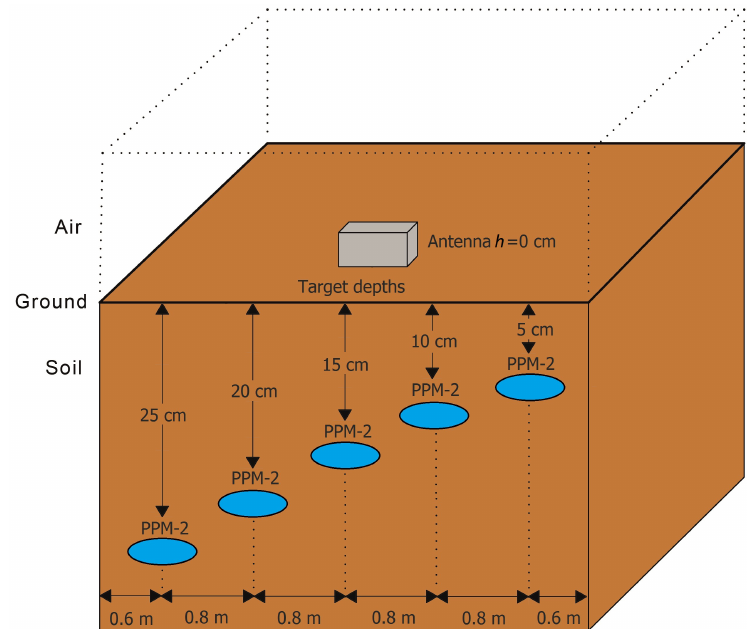
Figure 20. Experimental setup of real